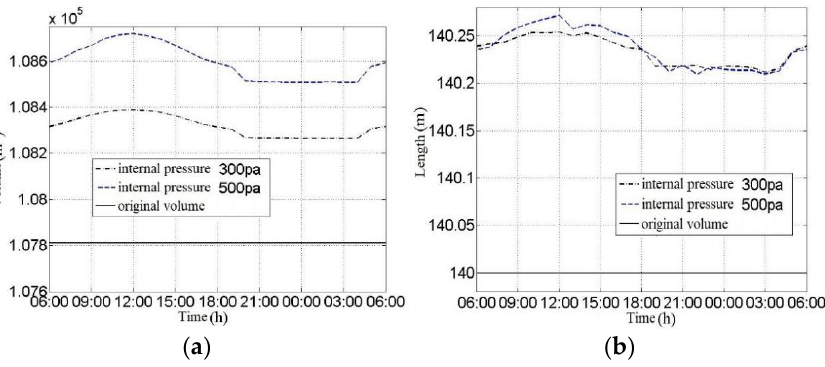
Figure 11. Changes in airship volume and length. ( a ) Airship volume. ( b ) Airship